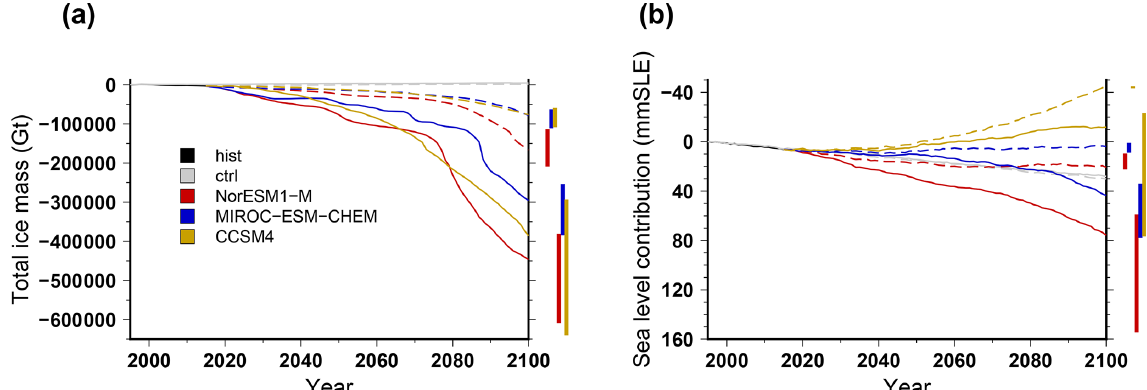
Figure 10. Simulated total ice mass change (a) and ice volume contributing to sea level rise (b) for projections under the different CMIP5 forcings using the RCP8.5 scenario and the medium oceanic sensitivity. For the projections, the solid lines stand for experiments that use a sub-shelf melting rate parameterisation calibrated against the Pine Island Glacier area only ( PIGL ), while the dashed lines stand for experiments that use the sub-shelf melting rate parameterisation calibrated against the Antarctic-wide dataset ( MeanAnt ). The evolutions begin with the historical simulation hist (1995–2015), and the control experiments ctrl and ctrl_proj are depicted in grey (solid and dashed, respectively). For each projection experiment, the vertical bar shows the minimal and maximal changes associated with the oceanic-forcing sensitivity to temperature change ( low and high ).